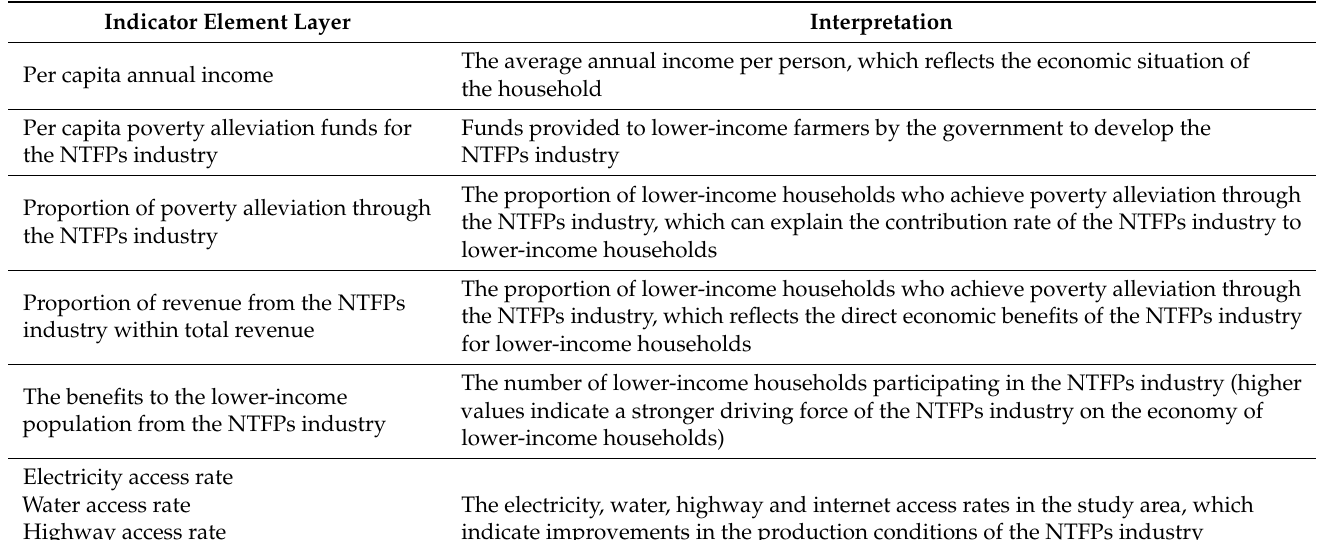
Table 3. The interpretation of the indicator element